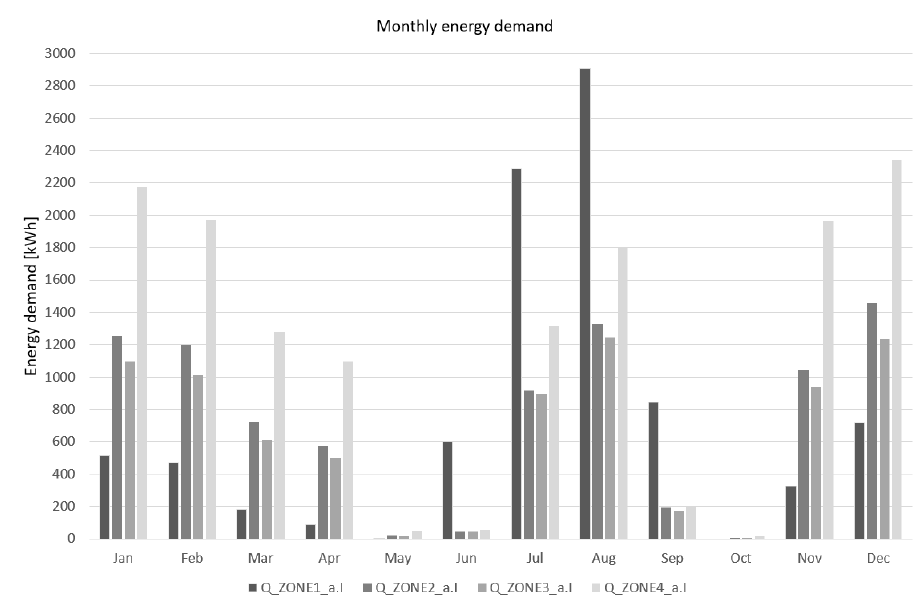
Figure 7. Monthly energy demand: comparison between thermal performance of different floors in current configuration.